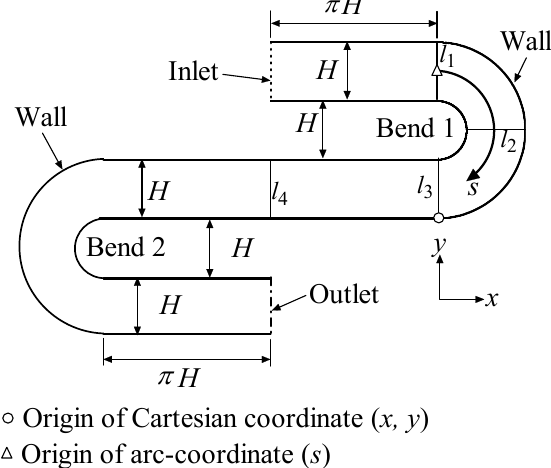
Figure 1. Computational model of the 2D infinite serpentine passage flow.